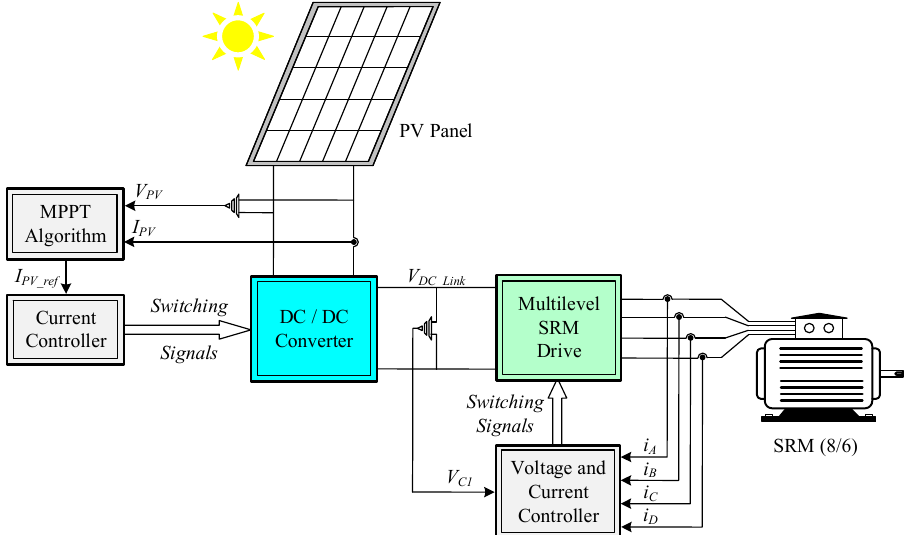
Figure 5. Control system for the proposed solution.